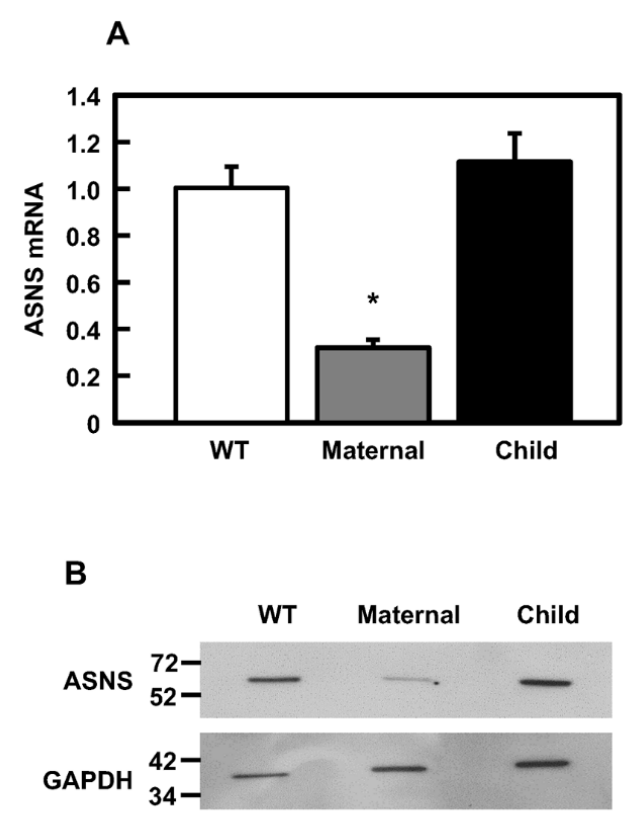
Figure 3. ASNS mRNA and protein evaluation in fibroblasts. ( A ) ASNS mRNA abundance, normal- ized to GAPDH mRNA and plotted relative to WT, as detected by qRT-PCR for WT, maternal, and child fibroblasts. An asterisk indicates that the value is statistically different from the WT, with a p -value of ≤ 0.05. ( B ) Immunoblot for ASNS protein in WT, maternal, and child fibroblasts. Ectopic expression in HEK293T cells and subsequent purification of